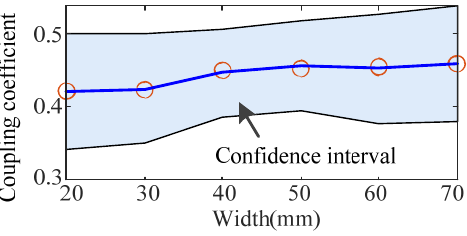
Figure 13. Fitting curve with different widths.